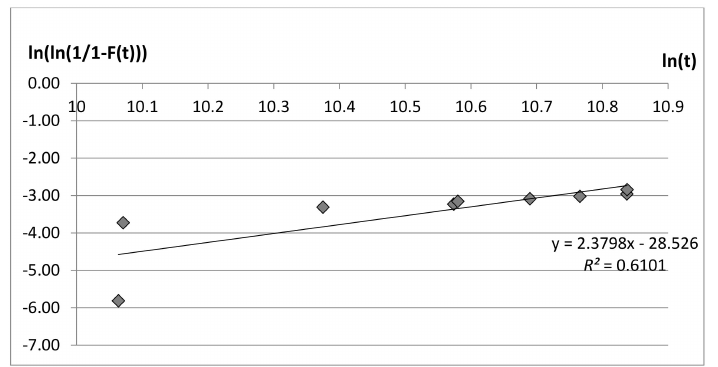
Figure 4. Weibull chart of board_OB—Prj3